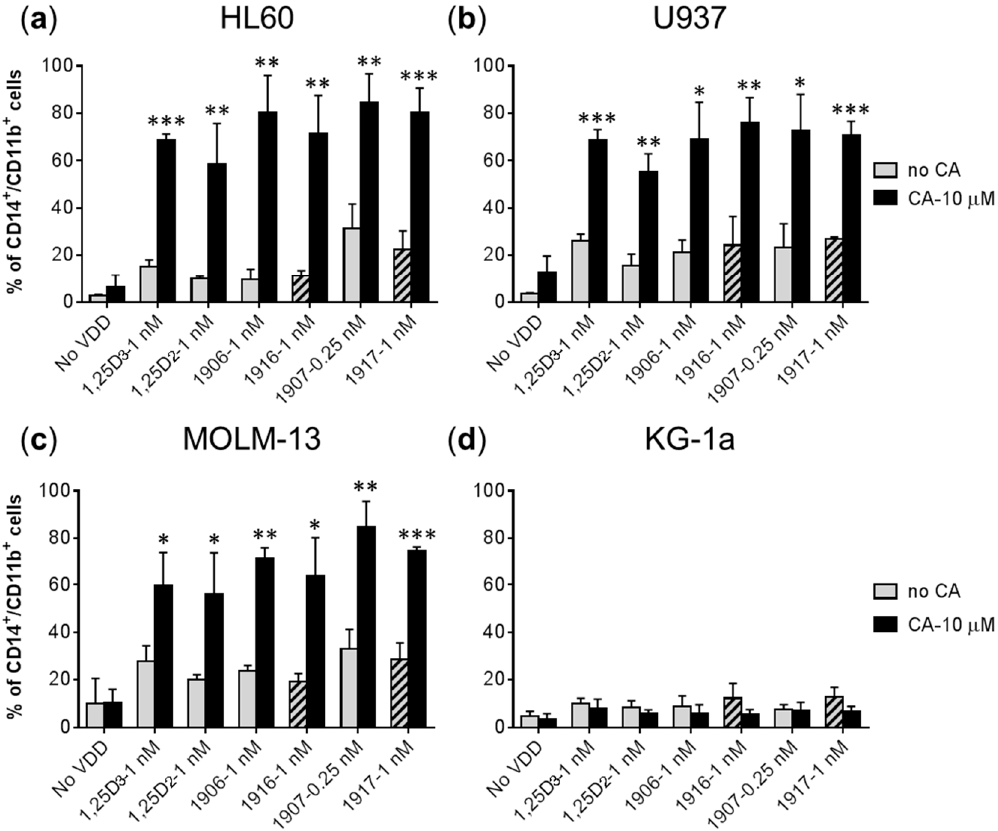
Figure 5. Enhancement of VDD-induced differentiation of AML cells by carnosic acid (CA) is cell type-dependent. Following incubations with the indicated agents for 96 h, the percentage of CD14 + /CD11b + cells was measured by flow cytometry ( a – d ). Hatched columns indicate the effects of the 24 Z analogs added alone. The data are the means ± SD ( n = 3). *, p < 0.05; **, p < 0.01; ***, p < 0.001 vs. sum of the effects of single agents.